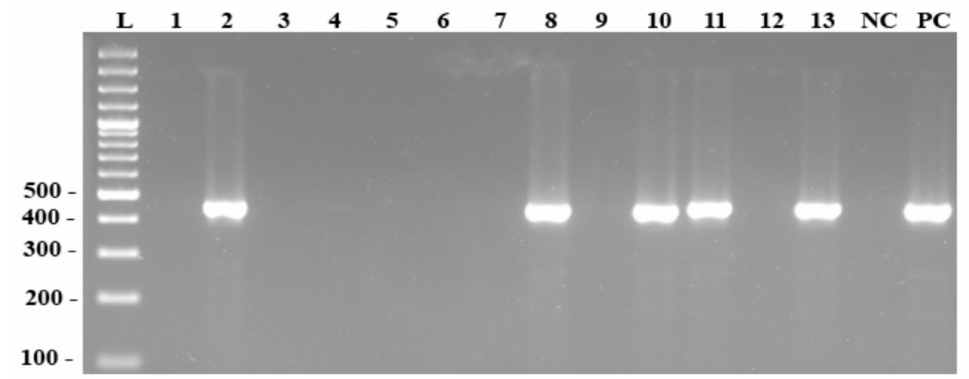
Figure 6. Electrophoretic separation of PCR products (466 bp) obtained with the use of Fusarium spp. specific primers ITS Fu1/Fu2; L—GeneRuler 100-bp DNA Ladder, 1–13—tested samples, NC—negative control, PC—positive control.